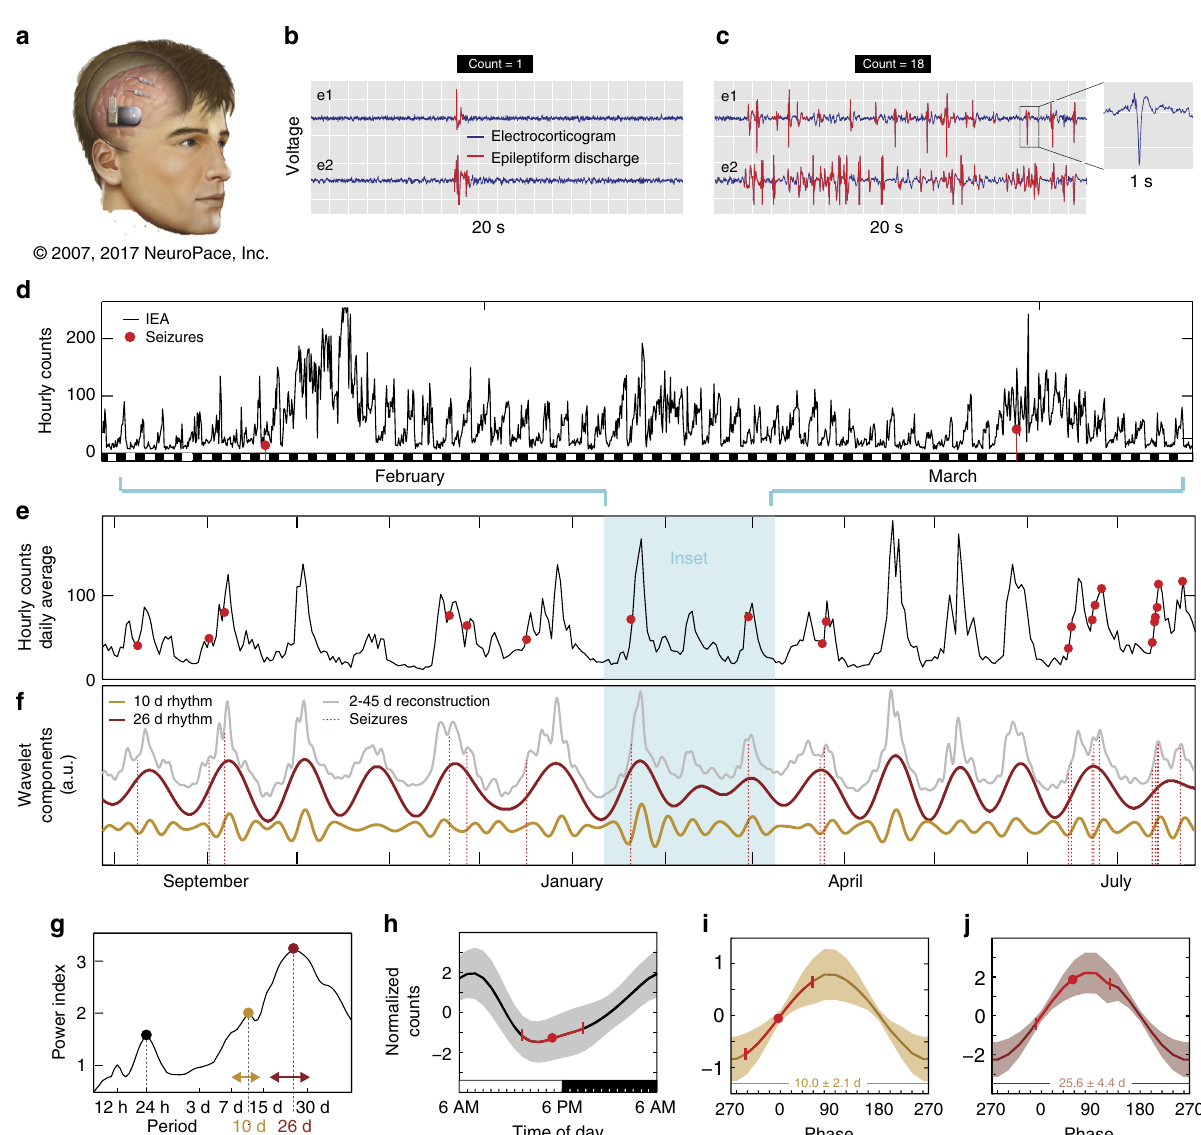
Fig. 1 Representative subject demonstrating circadian and multidien rhythms in IEA, as well as preferential timing of seizures. a RNS System comprising cranially implanted neurostimulator connected to intracranial leads (image used with permission from NeuroPace, Inc.). b EEG showing a single- epileptiform discharge (spike) in channels corresponding to left (e1) and right (e2) hippocampal leads. c EEG recorded 1 week later at the same time of day showing higher count of epileptiform discharges, i.e., higher IEA. Inset magni fi es one typical element to show waveform morphology. Hourly ( d , cyan inset) and daily ( e ) fl uctuation in IEA in one subject over 2 and 12 months, respectively. Red dots indicate times of seizure occurrence. f Wavelet decomposition revealing two component multidien rhythms with periodicities of 10 and 26 days. Combining all multidien wavelet coef fi cients reconstructs the daily IEA time-series (gray curve, 2 – 45 d, Pearson correlation r = 0.93, p = 0). g Corresponding periodogram showing ultradian (12 h), circadian (24 h), and multidien (10 and 26 d) peaks in periodicity. Period length displayed on the x -axis, and power index (square root of spectrogram power) on the y -axis. Horizontal double-arrows show span of corresponding wavelet coef fi cients included for ( f ) (peak period ± 33%). h Average normalized amplitude of the circadian rhythm as a function of time of the day showing phase preference of seizures near the trough at 5 PM ( n = 74 seizures, mean ± SD in red, p = 10 − 4 , Omnibus test, see Methods section). Black and white rectangles ( d , h ) represent night (6PM – 6AM) and day (6AM – 6PM), respectively. i , j Average normalized amplitude of the 10 d and 26 d IEA rhythms as a function of their underlying phase ( x -axis, full 360 degrees phase; y -axes have different scales). Seizures demonstrate phase preference for the up-slope of both rhythms (10 and 26 days, n = 66 seizures, mean ± SD in red, p = 0.0002 and p = 0.002, respectively, Omnibus Seizure risk modulation by circadian and multidien rhythms . 1.2, 95% CI: 1.1 – 1.3) to very large effect sizes (RR 24.5, 95% CI: We estimated differences in effect size across subjects by calcu- 3.4 – 175.9) in subjects with high and low seizure rates, respec- lating the risk of having a seizure at a given circadian or multidien tively, and a large effect-size summary across subjects phase relative to the risk of not having a seizure at the same (unweighted RR 6.8, 95% CI: 3.1 – 15.1, Fig. 5). Although the phase. When combining phase information from the underlying relative modulation of seizure occurrence by circadian and mul- circadian and multidien rhythms, we found small (risk ratio (RR) tidien rhythms varied across subjects, the highest risk ratio was